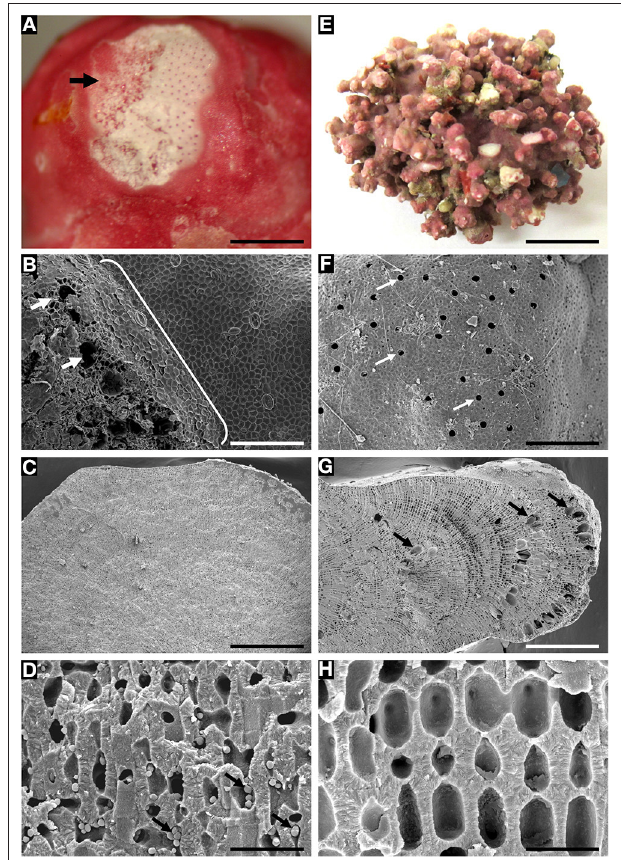
FIGURE 5 | Rhodolith species with sloughed tetrasporangial sori and epithallial layers showing endolithic cells (A–D) , and species with non-sloughed tetrasporangial sori (E–H) lacking endolithic cells. (A–D) Sporolithon sinusmexicanum ( A,C,D = specimen LAF6970B from Dry Tortugas vicinity [24 ◦ 31.494’N, 83 ◦ 19.793’W, 69m]; B = specimen LAF6956A from Sackett Bank, LA [28 ◦ 38.0’N, 89 ◦ 33.028’W, 69m]). (A) Thallus surface showing tetrasporangial sorus (arrow) in the process of sloughing. Scale bar = 500 µ m. (B) Disintegrating tetrasporangial sorus showing exposed tetrasporangial compartments (arrows) and sloughing epithallial cells (bracket). Scale bar = 160 µ m. (C) Longitudinal fracture of rhodolith protuberance showing lack of buried tetrasporangial compartments. Scale bar = 720 µ m . (D) Perithallial cells with putative endolithic cell stages (arrows). Scale bar = 32 µ m. (E–H) Sporolithon sp. nov. (LAF7260). (E) Thallus habit. Scale bar = 1.1cm. (F) Thallus surface with tetrasporangial sorus showing lack of sloughing and pores of intact tetrasporangial compartments. Scale bar = 176 µ m. (G) Longitudinal fracture of rhodolith protuberance showing layers of unshed and buried tetrasporangial compartments (arrows). Scale bar = 400 µ m. (H) Perithallial cells lacking endolithic cell stages. Scale bar = 22 µ